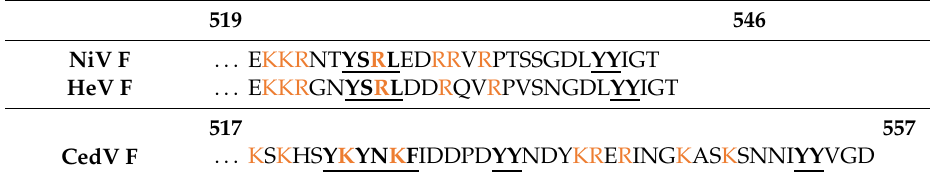
Table 1. Boldface and underlined letters highlight (potential) endocytosis signals. Numbers above the sequence indicate the amino acid position. Cytoplasmic tails for NiV and HeV F proteins range from amino acid positions 519 to 546, cytoplasmic tail for CedV F is predicted for amino acid positions 517 to 557. Basic aa’s that have been shown to be of importance for fusion protein functionality are highlighted in